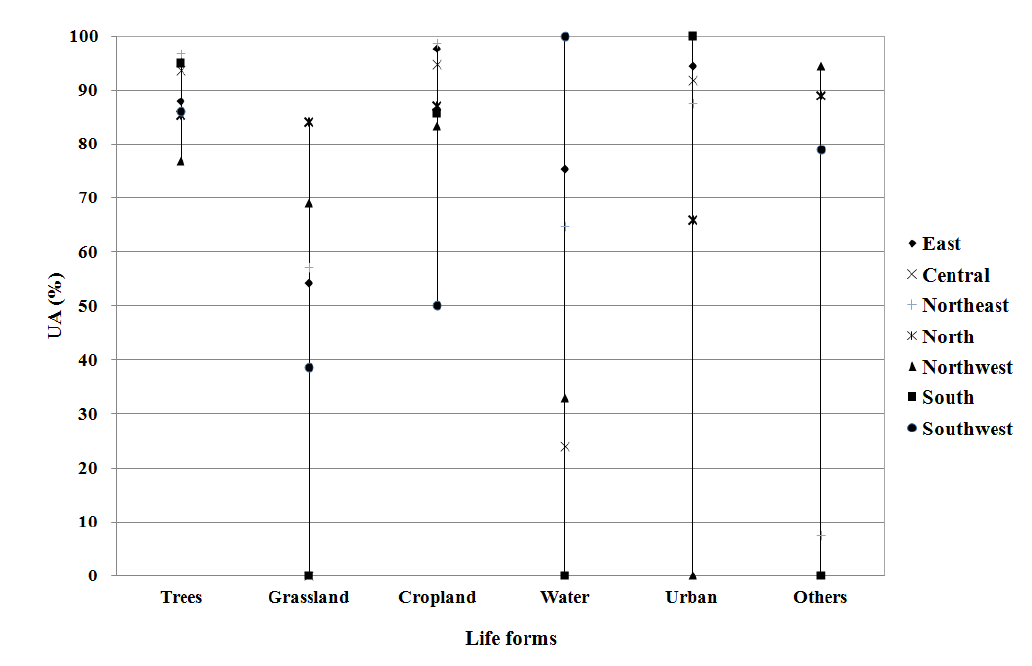
Figure 8. User’s accuracy for GLCD-2005 over seven geographical regions of China.